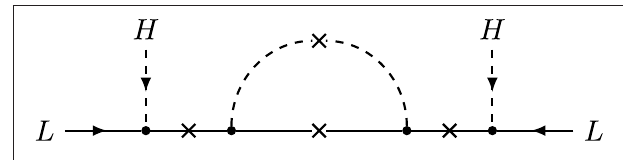
FIGURE 8 | Radiative inverse